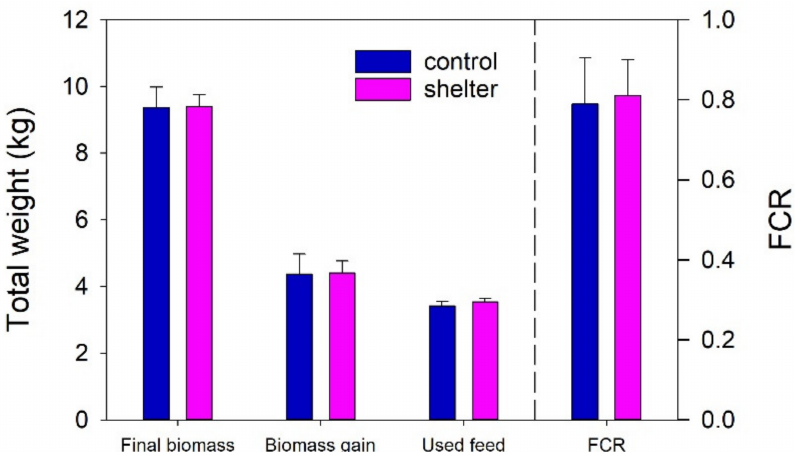
Figure 2. Growth performance (tank-based) of Control and Shelter rainbow trout ( Oncorhynchus mykiss ) fingerling groups during the 30 day experimental period. Data represent the mean and SD of n = 3 tanks per treatment. Student’s t -tests showed no treatment effect for Final biomass ( p = 0.939), Biomass gain ( p = 0.939), Used feed ( p = 0.256) or feed conversion ratio (FCR, p =